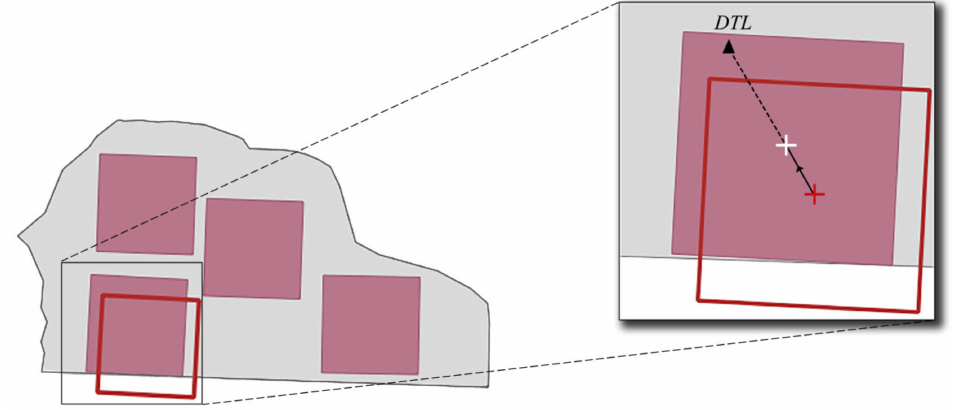
Figure 8. Inward